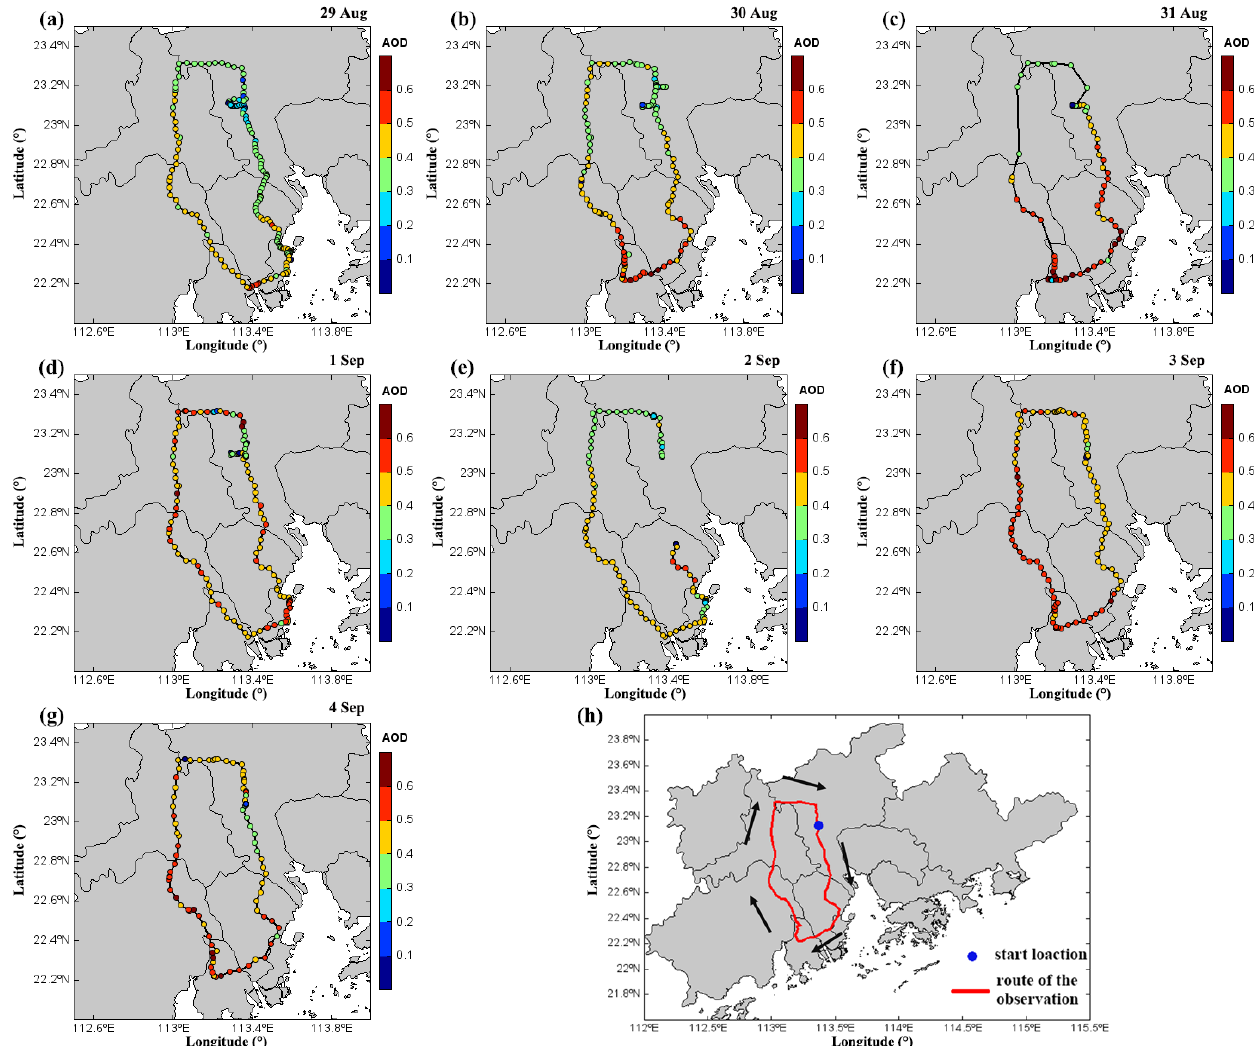
Figure 3. (a–g) Aerosol optical depth (AOD) measured at 532nm with the MPL in the route from 29 August to 4 September 2020, and (h) Guangdong–Hong Kong–Macao Greater Bay Area and route